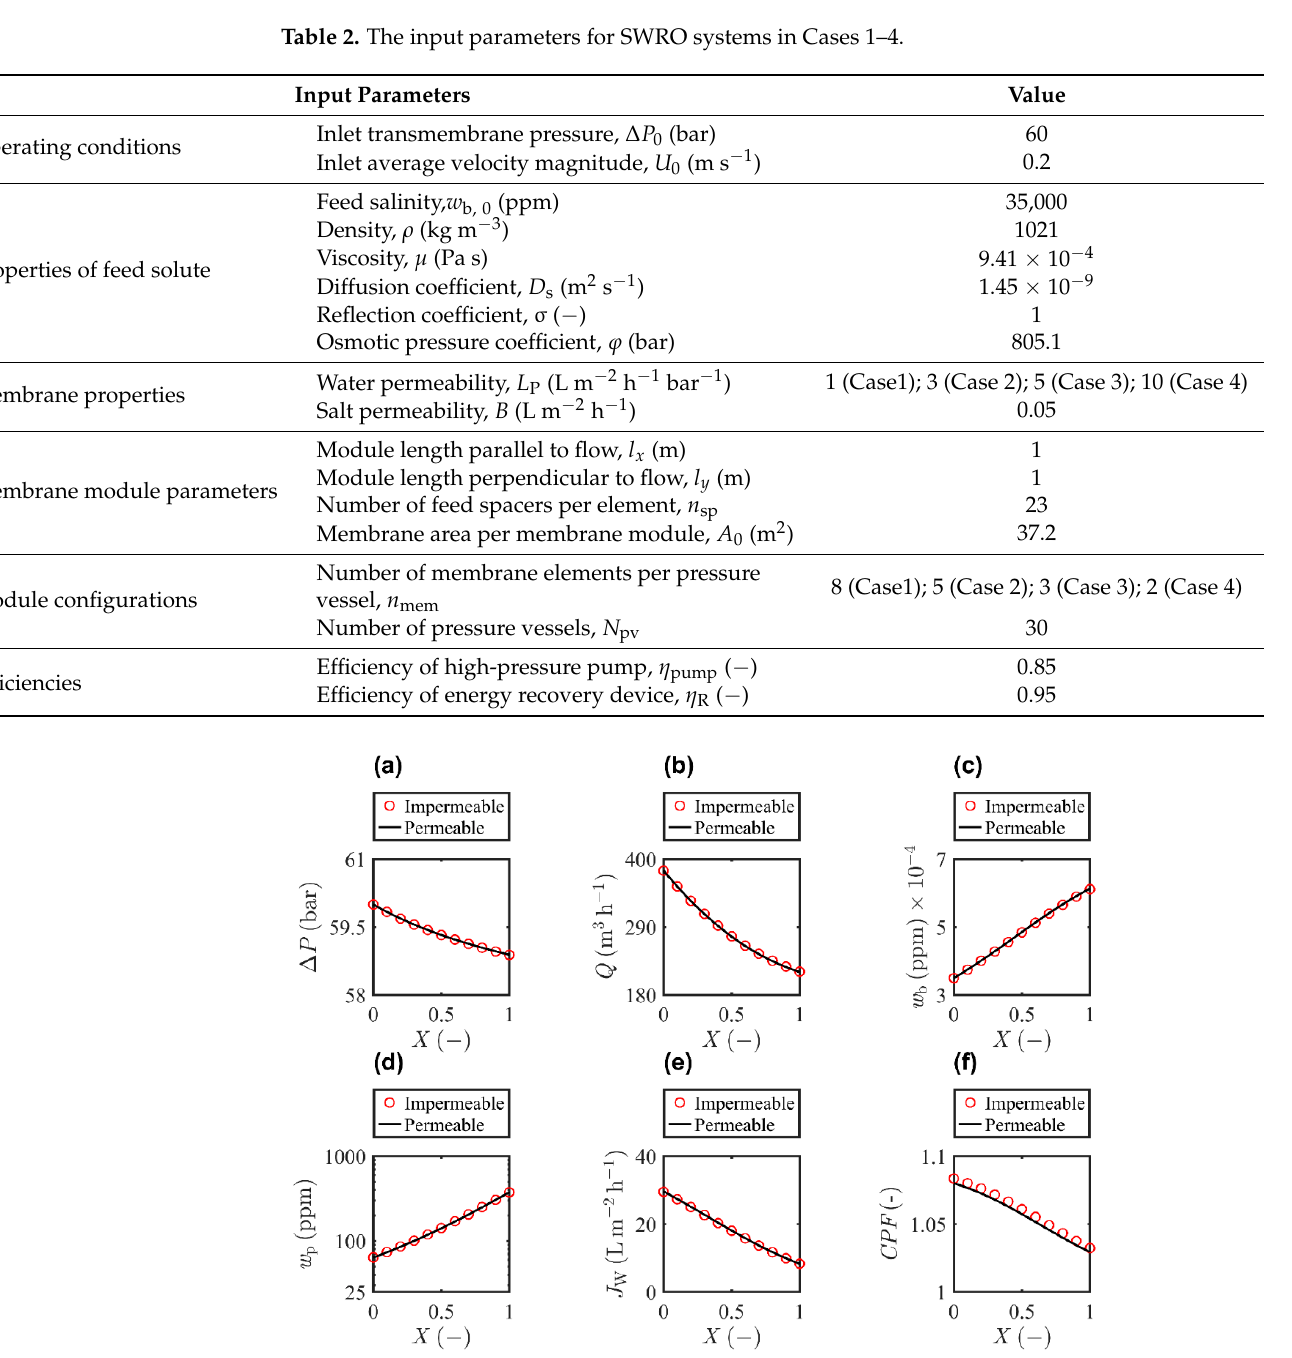
Figure 9. The simulated results at the system level using the impermeable and permeable wall mod- els with the feed salinity ( b, 0 w = 35,000 ppm), water recovery ( r,0 R = 50%), pump efficiency (0.85), energy recovery device efficiency (0.95) and water permeability ( p L = 3 L m − 2 h − 1 bar − 1 ). ( a ) Trans- membrane pressure, P Δ (bar), ( b ) Flow rate, Q (m 3 h − 1 ), ( c ) Brine salinity, b w (ppm), ( d ) Permeate salinity, p w (ppm), ( e ) Permeation flux of water, W J (L m − 2 h − 1 ), ( f ) CP factor, CPF ( − ) along the di- mensionless length ( X ).